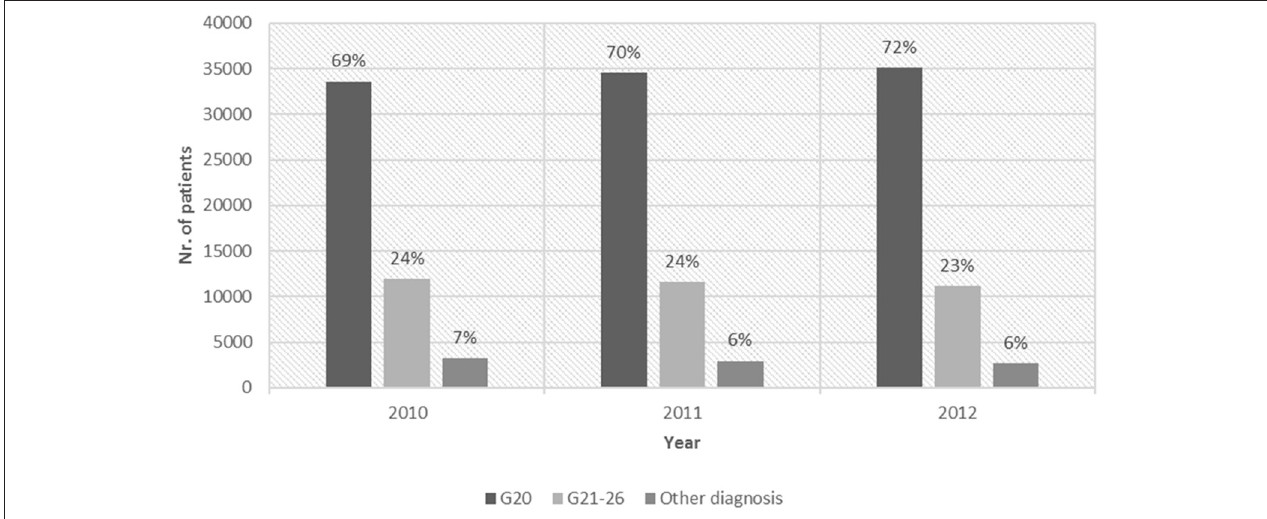
FIGURE 2 | Refill of N04 ATC drugs: with G20 diagnosis, with G21–26 diagnosis and with other diagnosis codes between 2010 and